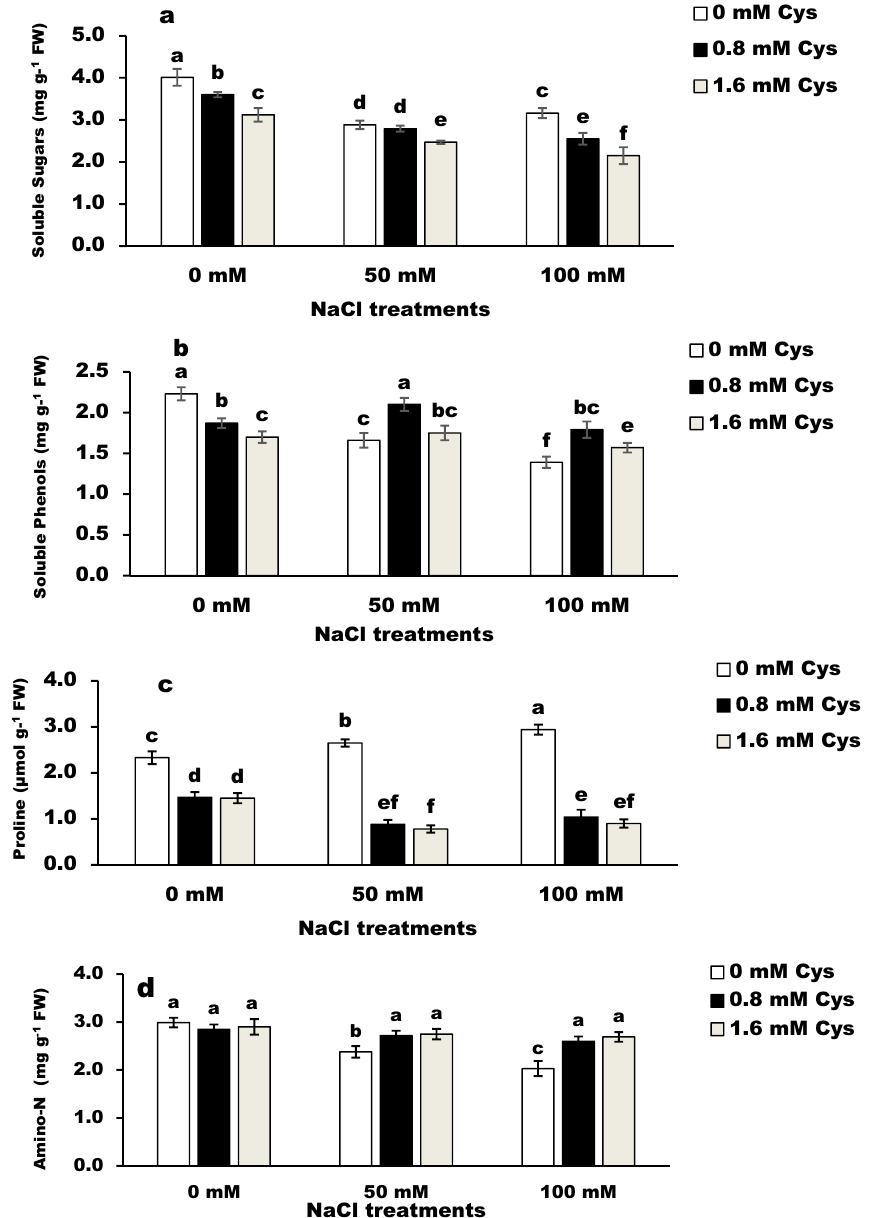
Figure 2. Effect of L-cysteine on soluble sugars ( a ), soluble phenols ( b ) proline ( c ), and amino-N ( d ) in salt- stressed flax plants. Differences are statistically significant at p < 0,05; vertical bars indicate ±